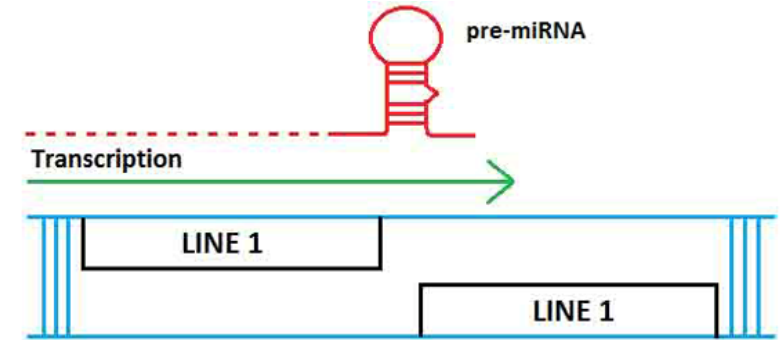
Figure 2. Schematic of proposed origin of TE-based miRNAs. When two related but not identical LINE1elements insert themselves near each other, but on opposite strands of the DNA (in blue), they can create a precursor miRNA containing an imperfect stem-loop upon transcription (red line). The pre-miRNA is shown above the arrow and transcription is indicated from the positive strand LINE1. The stem is potentially recognized and processed by the endogenous RNAi machinery. The pre-miRNA stem-loop depicted is representational. Modified from